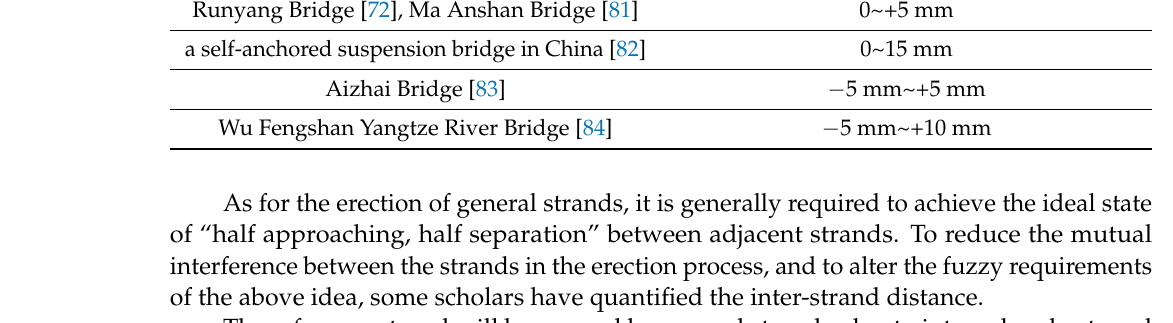
Table 3. Control standards for erection accuracy of various bridges.